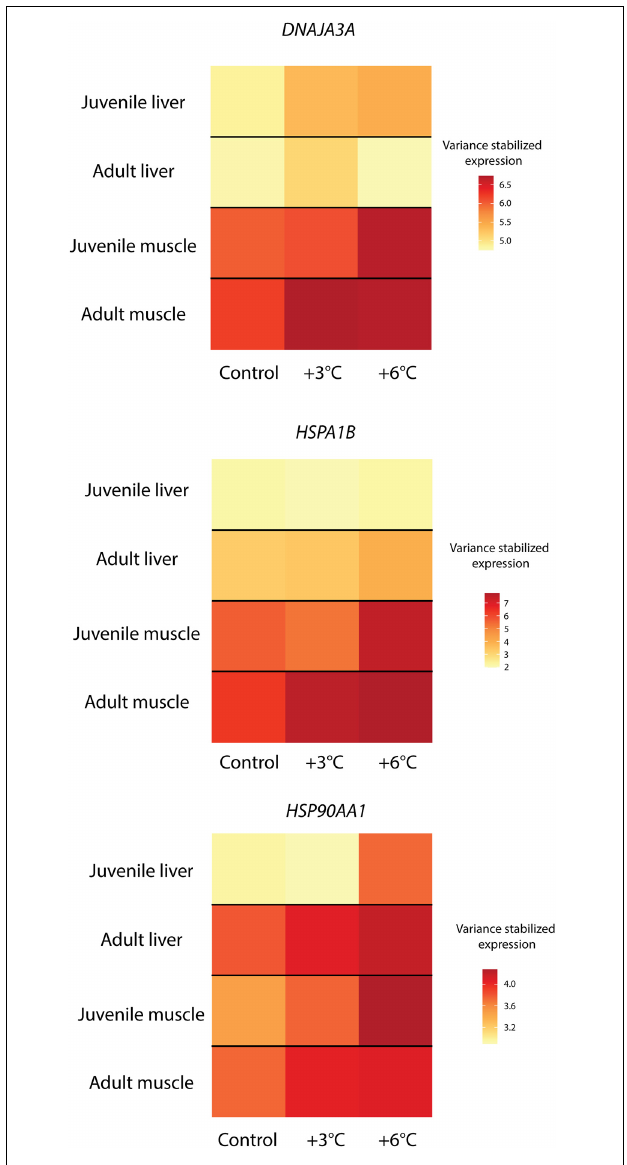
FIGURE 5 | Heatmap of variance stabilized expression data for three heat shock proteins. The values for each gene represent the average of the variance stabilized data for all samples in a specific treatment. Note that juvenile liver, adult liver, juvenile muscle, and adult muscle datasets were transformed separately, so comparisons of expression levels for a particular gene should be made within rows, and not columns, of the matrix. Each gene has an individual color scale, where darker reds indicate higher levels of expression, and lighter yellows indicate lower levels of